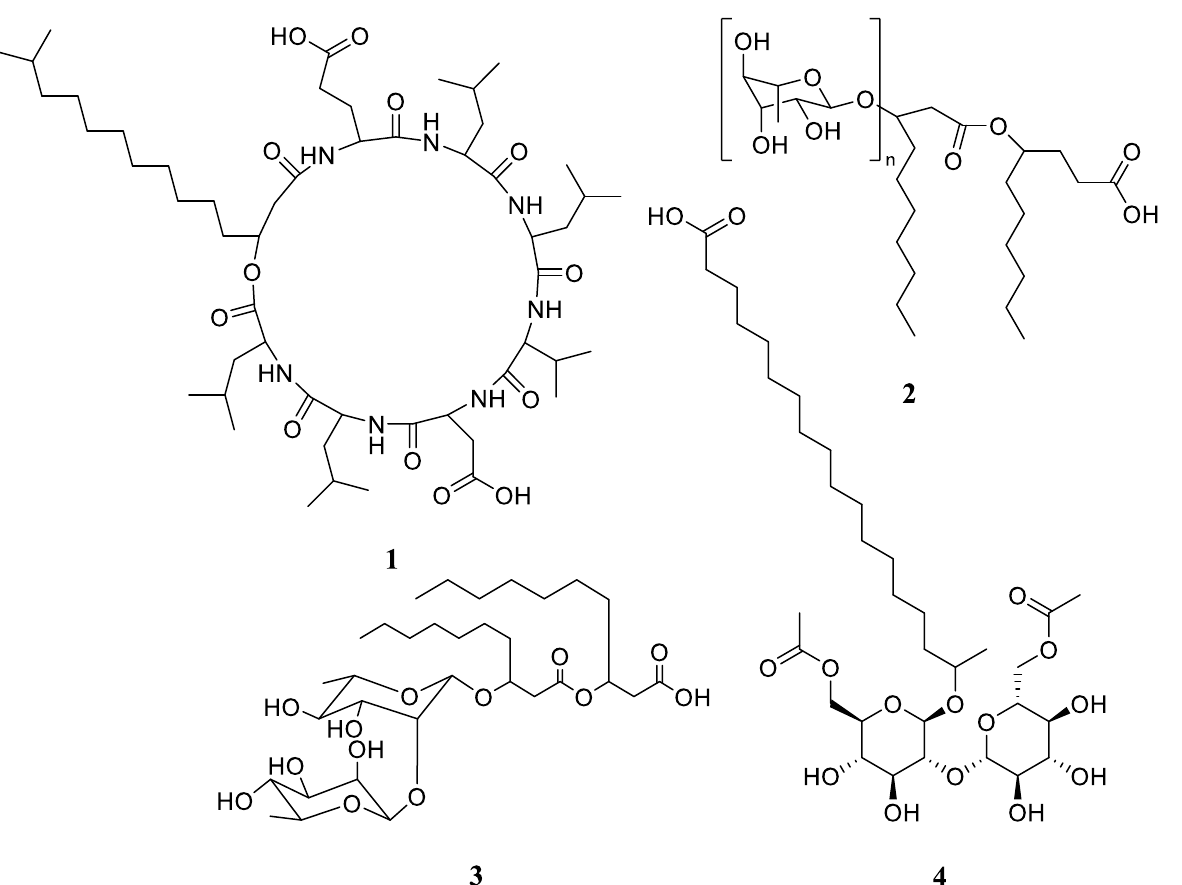
Figure 1. Chemical structures of surfactin A ( 1 ), BS glycolipid ( 2 ), rhamnolipid ( 3 ), and sophorolipid ( 4